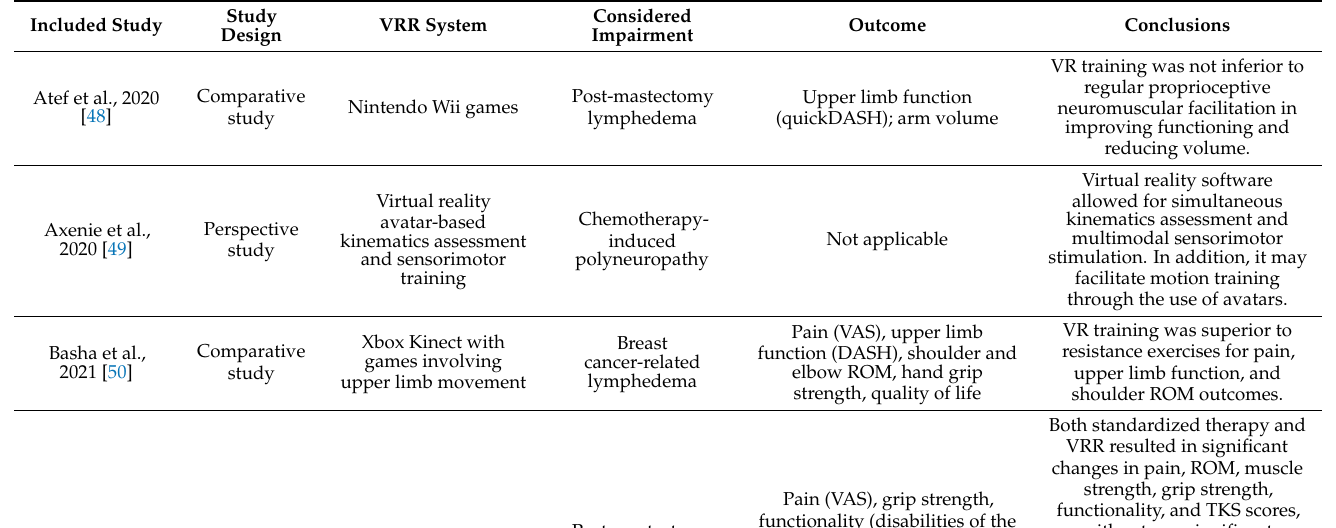
Table 1. Features of the included studies.